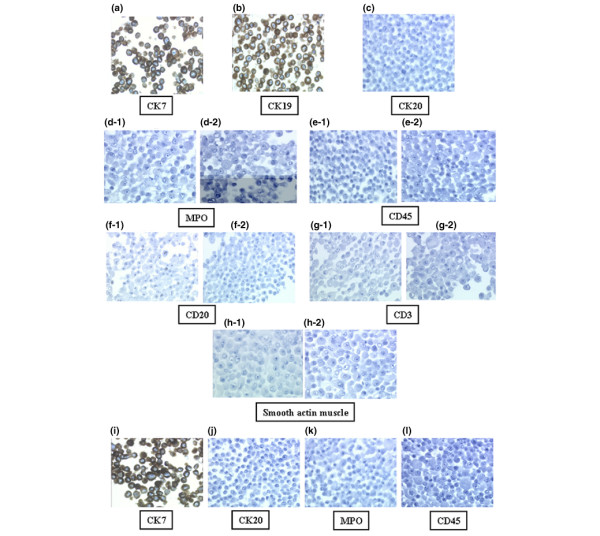
Immunocytochemical analysis of salivary epithelial cells. Cells were obtained from minor salivary glands (a–e) and the HSG cell line (f–i). Positive staining for cytokeratin 7 (a) and cytokeratin 19 (b) and the absence of staining with cytokeratin 20 (c) indicates the specificity of ductal epithelial cell origin. The absence of staining for myeloperoxidase (MPO) (d), CD45 (e), CD20 (f), CD3 (g) and smooth muscle actin (h) before (subpanels 1 in (d–h)) and after (subpanels 2 in (d–h)) stimulation with IFN-α excludes the possibility of contamination with myeloid cell. Positive staining with cytokeratin 7 (i) and the absence of staining with cytokeratin 20 (j) indicate the ductal epithelial origin of HSG cell lines. Negative staining with myeloperoxydase (MPO) (k) and CD45 (l) excludes the possibility of contamination with myeloid cells.